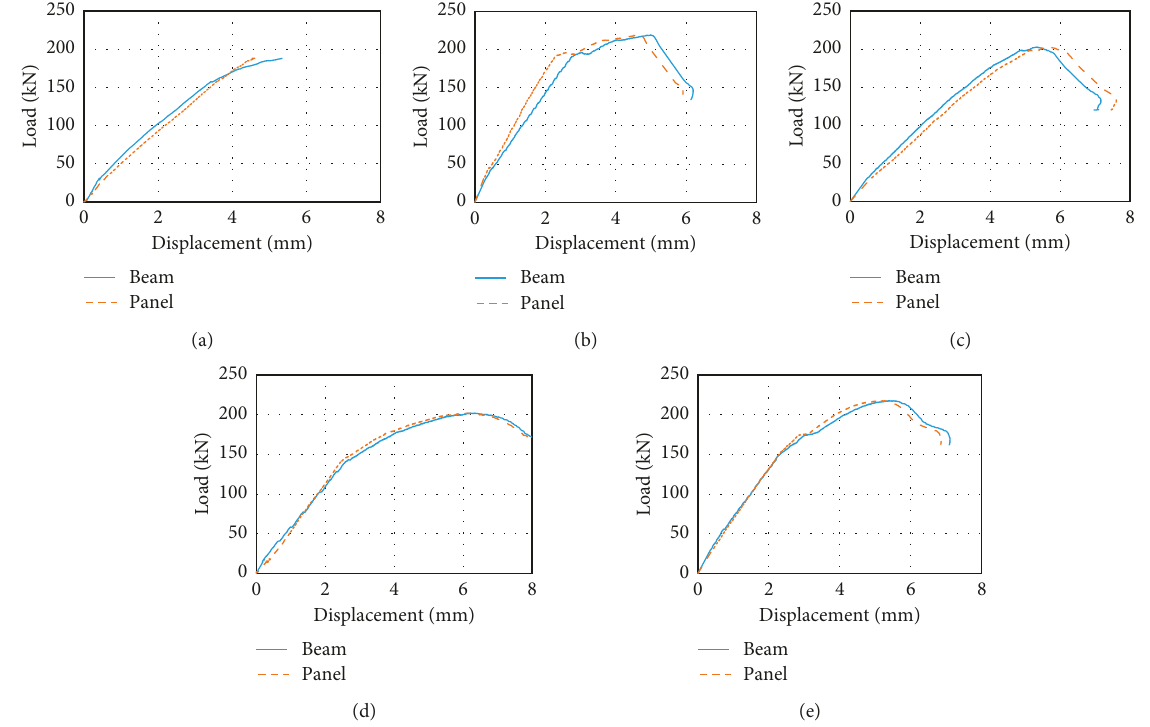
Figure 10: Load versus vertical displacement of the RC beam and SFRC panel with various connection details. (a) 1.5F-Epoxy. (b) 1.5F- 4D12. (c) 1.5F-6D12. (d) 1.5F-6D10. (e) 1.5F-8D10.